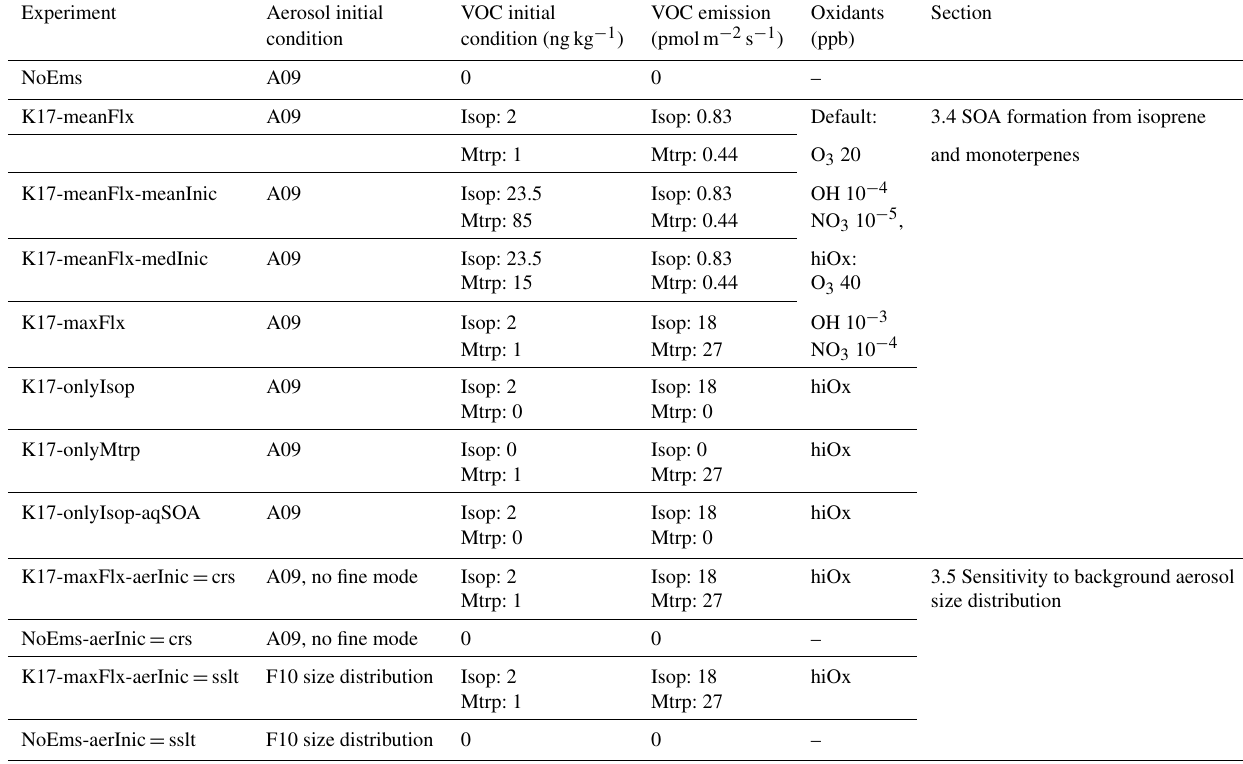
Table 2. Model experiments for VOC emission.